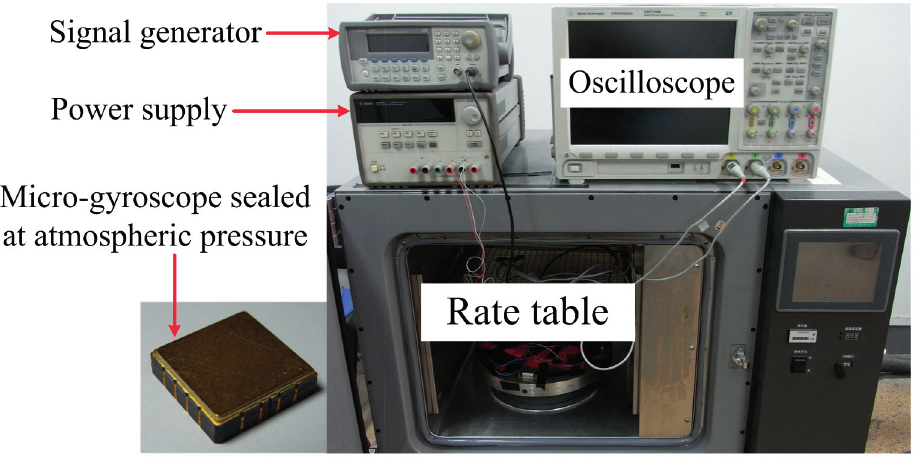
Figure 12. The photos of the micro-gyroscope and the experiment setups.